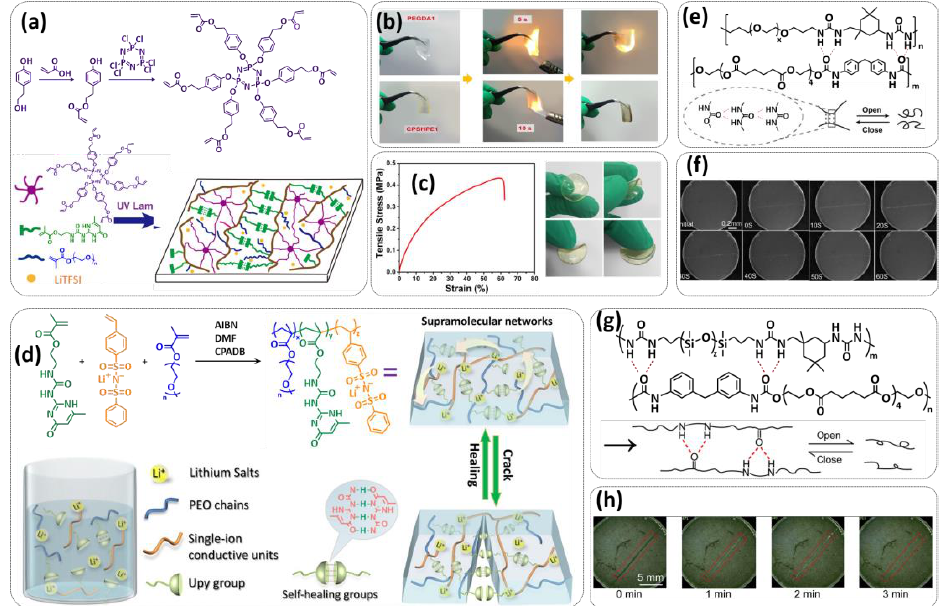
Figure 4. ( a ) Schematic illustration of the synthesis route of HCP followed by the fabrication of CPSHPEs via photopolymerization under UV irradiation. ( b ) States of the membrane without (PEGDA1) and with HCP (CPSHPE1) at different burning times. ( c ) Mechanical properties of the CPSHPE1 (intercept: folding of the CPSHPE1). Reproduced with permission from [72]. Copyright © 2020, American Chemical Society. ( d ) Schematic illustration for the preparation process of SIPE membranes. Reproduced with permission from [90]. Copyright © 2021, American Chemical Society. ( e ) Supramolecular structure and dynamic hydrogen bonding in SHSPE. ( f ) The self-healing process of SHPE after cutting. Reproduced with permission from [70]. Copyright © 2019, Wiley-VCH Verlag GmbH & Co. KGaA, Weinheim. ( g ) Molecular structure and dynamic hydrogen bonding of SHSPE_2 and ( h ) optical images of its self-healing at room temperature. Reproduced from [86], with permission from the Royal Society of